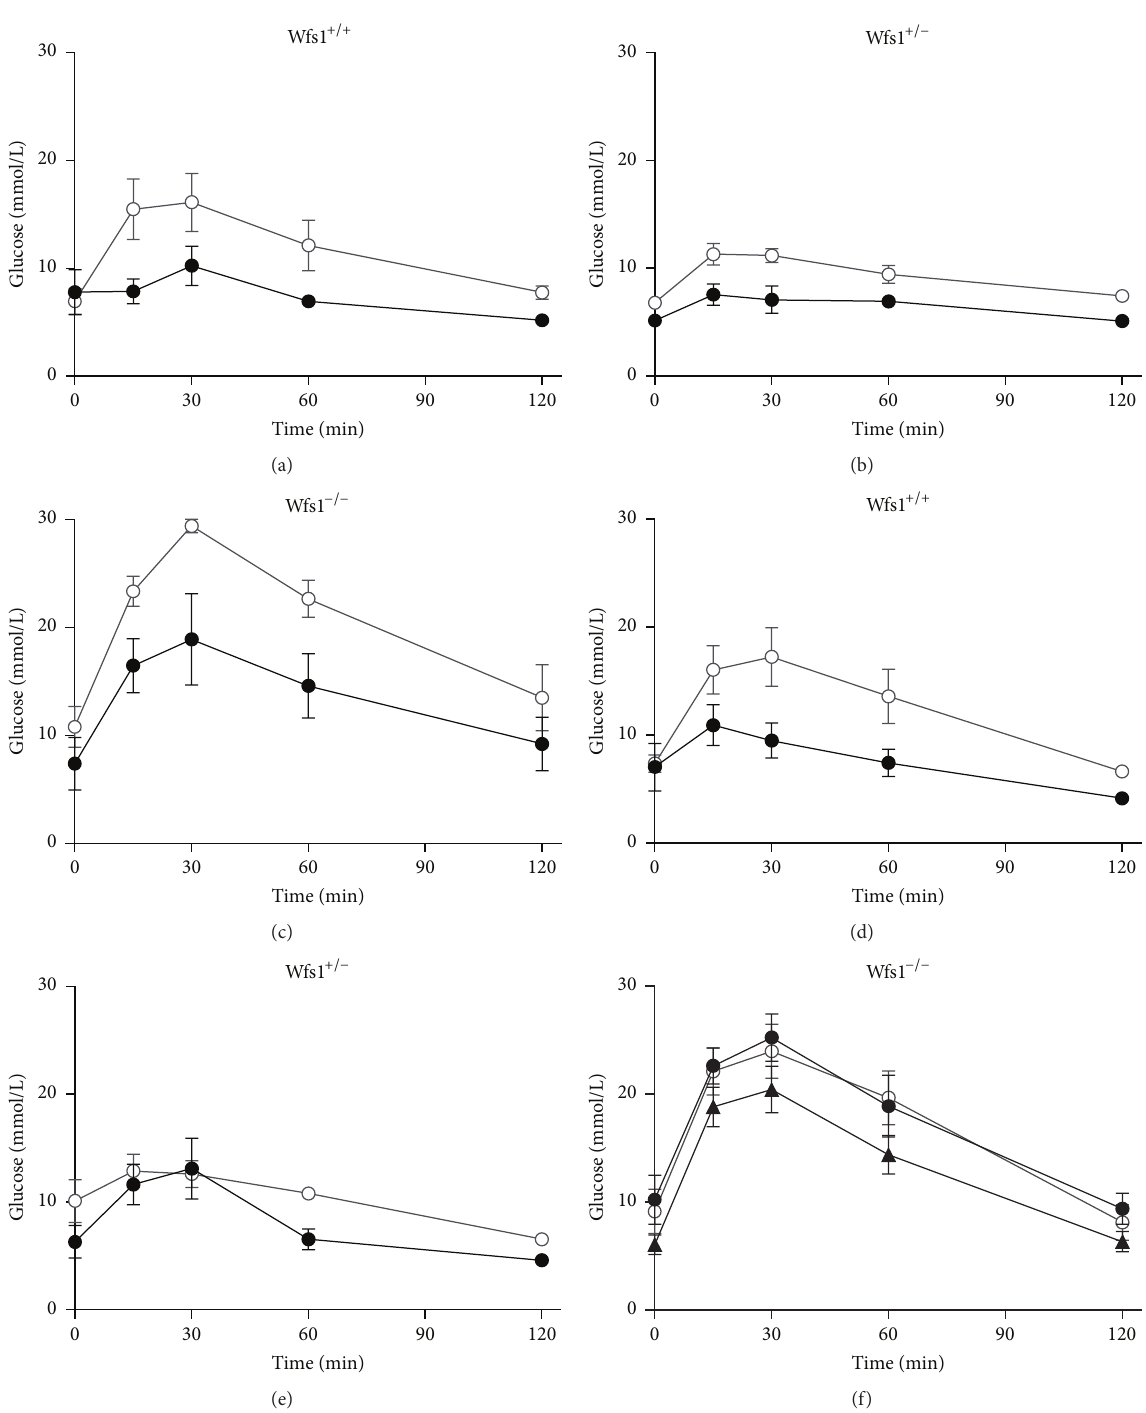
Figure3:GlucoselevelsduringIPGTTwithexenatideinWfs1 +/+ (a),Wfs1 +/− (b),andWfs1 −/− mice(c);saline(whitedots),exenatide10 𝜇 g/kg (black dots), and glipizide in Wfs1 +/+ (d), Wfs1 +/− (e), and Wfs1 −/− mice (f); saline (white dots), glipizide 0.6 mg/kg (black dots), and glipizide 2 mg/kg (black triangles). 𝑛 = 8 in all